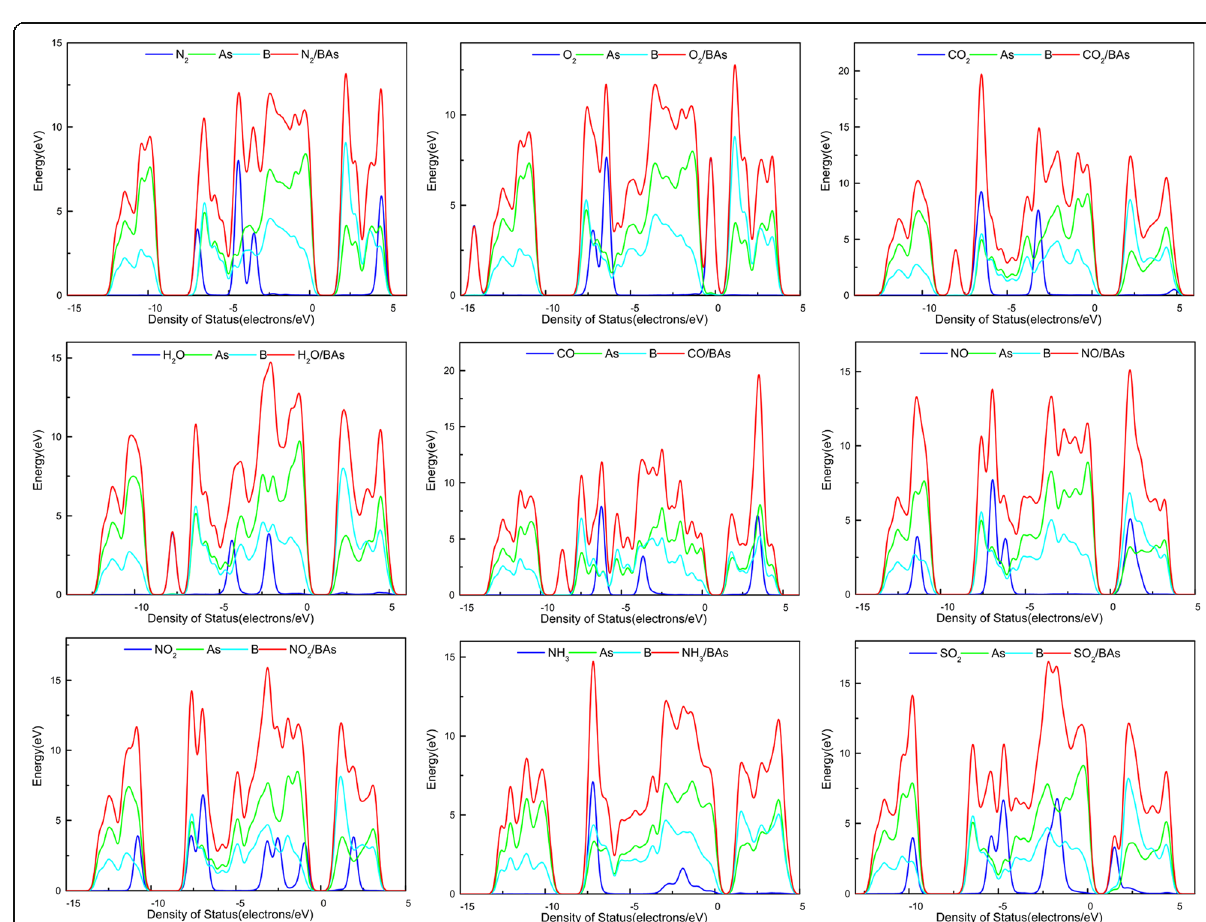
Fig. 3 Density of states (DOS) of N 2 /BAs ( a ), O 2 /BAs ( b ), CO 2 /BAs ( c ), H 2 O/BAs ( d ), CO/BAs ( e ), NO/BAs ( f ), NO 2 /BAs ( g ), NH 3 /BAs ( h ) and SO 2 /BAs ( i